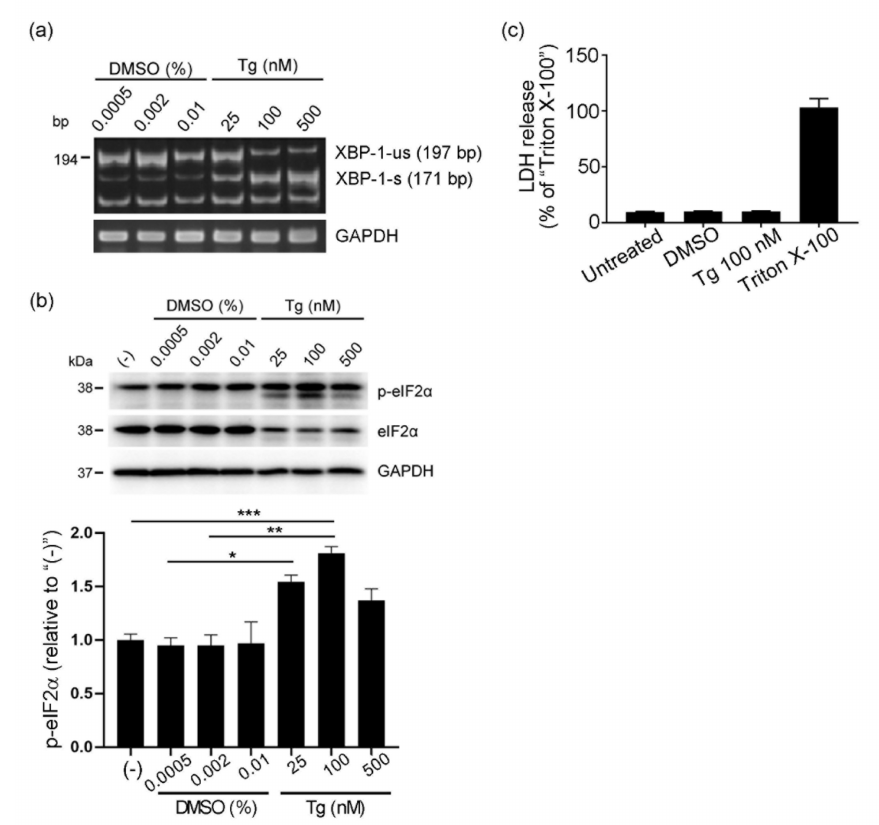
Figure 2. Thapsigargin-induced ER stress in BeWo cells. BeWo cells were treated with thapsigargin (Tg, 25–500 nM) or DMSO for 1 h at 37 ◦ C. After samples were washed three times with phosphate- buffered saline (PBS), culture media were replaced with fresh Opti-MEM and cells were cultured for 24 h at 37 ◦ C. Cells were then harvested, and induction of ER stress and cytotoxicity of thapsigargin treatment were analyzed. ( a ) mRNAs of XBP-1 and GAPDH were assessed by using RT-PCR. XBP 1-s, spliced fragments of XBP-1; XBP 1-us, unspliced fragments of XBP-1. ( b ) Expression levels of the ER stress marker phosphorylated eIF2 α (p-eIF2 α ) were analyzed by using Western blotting. GAPDH served as the loading control. The graph shows quantification of p-eIF2 α . Data represent means ± SE (n = 3). ( c ) Cytotoxicity of thapsigargin treatment (Tg) was assessed by means of the LDH release assay. Results are presented as a percentage of the values of 2% Triton X-100-treated cells, which caused the maximum release via complete membrane disruption. Data represent means ± SE (n =